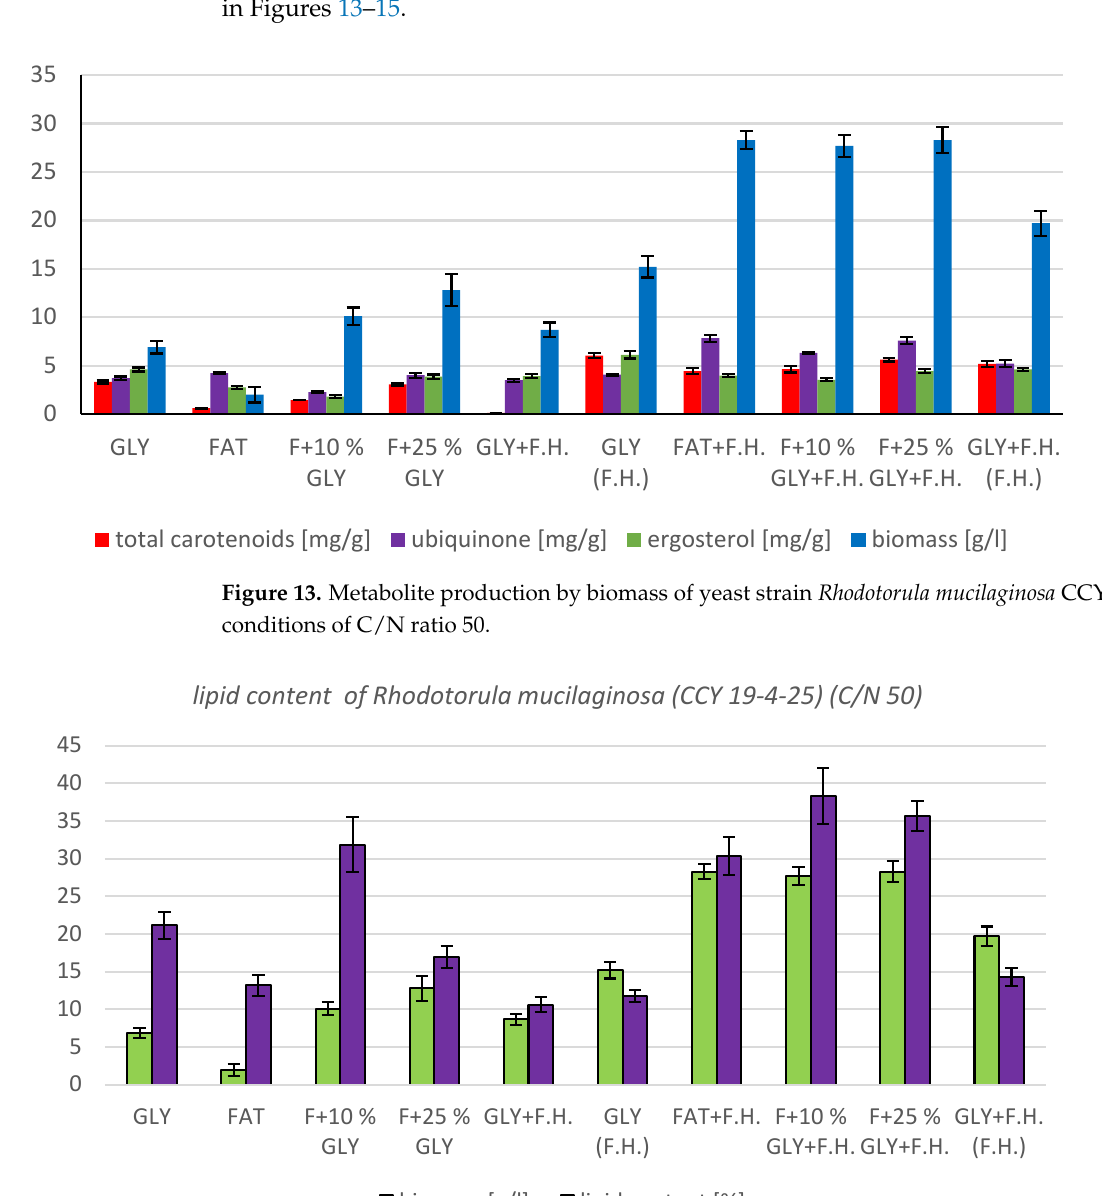
Figure 15. Fatty acid distribution in lipids of yeast strain Rhodotorula mucilaginosa in conditions of C/N ratio 50. 3.5. Flask Cultivations of Strain Rhodotorula mucilaginosa (CCY 20-9-7) 3.5.1. Results of C/N Ratio 25 Biomass production reached its two highest values in F + 25% GLY + F.H (17.2 g/L) and GLY (F.H.) (17.8 g/L) media. The highest concentrations of carotenoids in the biomass were observed in cultivations in F + 10% GLY (1.324 mg/g) and GLY (2.241 mg/g) media. Ergosterol was observed in high concentrations in the biomass cultured in GLY (F.H.) (4.945 mg/g) and GLY + F.H. (F.H.) (4.969 mg/g) media. The highest ubiquinone produc- tions were achieved in FAT + F.H (5.418 mg/g) and GLY + F.H. (F.H.) (5.988 mg/g) media. The most significant lipid accumulation was achieved in the FAT medium (46.79%), but the highest producti on of SFA (2.97 g/L) was observed in the GLY (F.H.) medium and the highest production of MUFA (1.24 g/L) and PUFA (1.22 g/L) was recorded in cultivation in the F + 10% GLY + F.H medium (Table S4, Supplementary). 3.5.2. Results of C/N Ratio 50